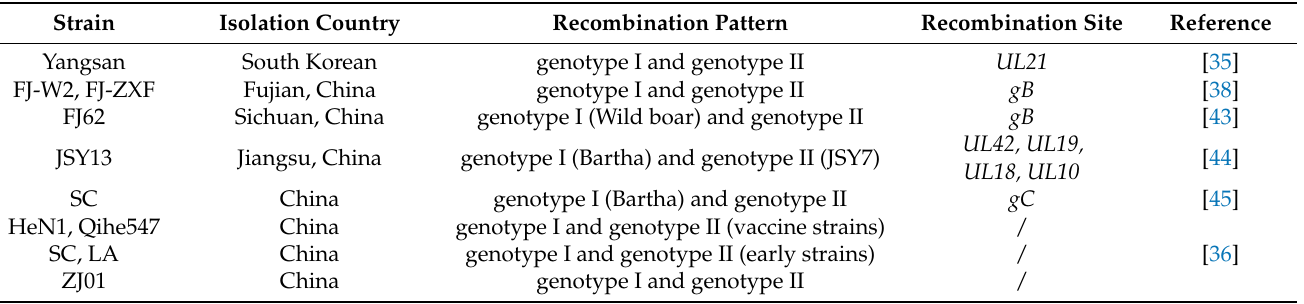
Table 2. The reported recombination events of